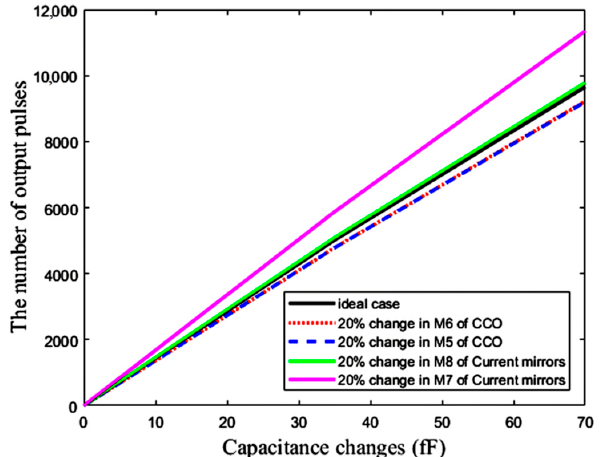
Figure 21. The effect of mismatch error on the capacitive sensor output after the elimination of offset.